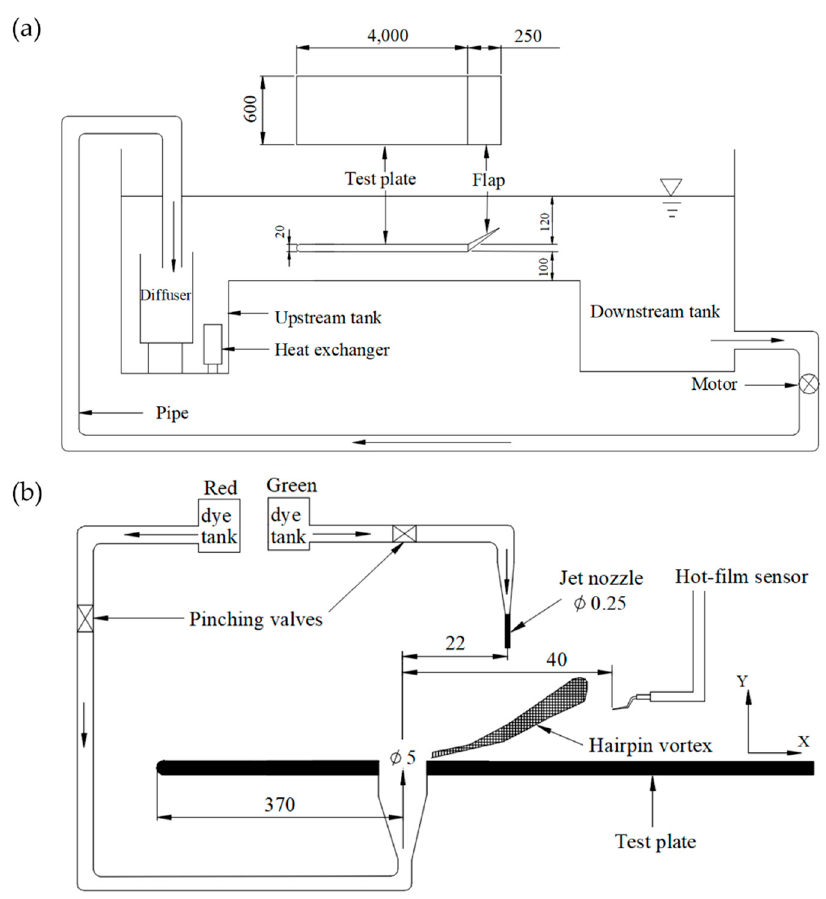
Figure 1. Experimental configurations: ( a ) water channel with test plate; ( b ) hairpin vortex control by jet with hot-film measurement.